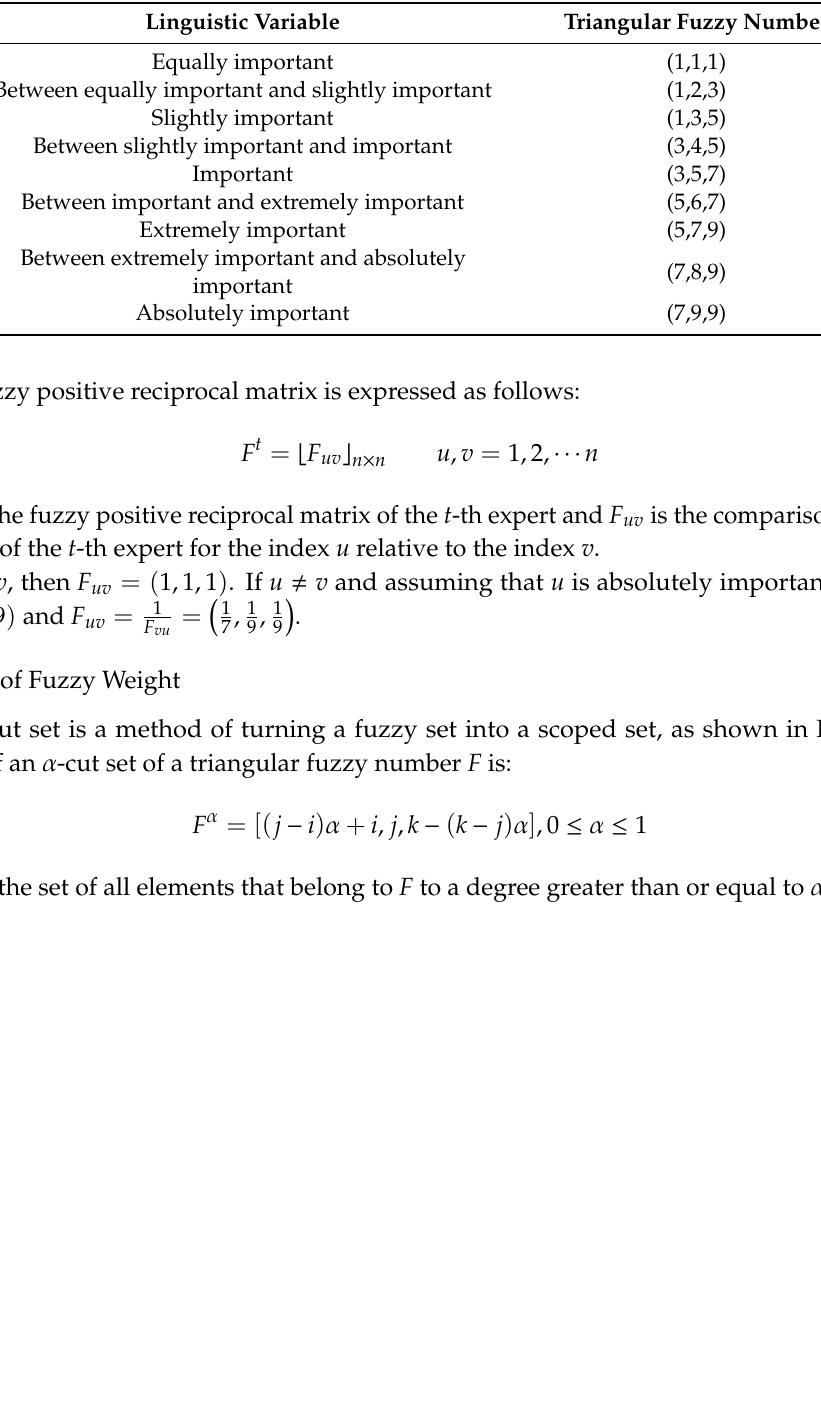
Table 3. Relative importance assessment